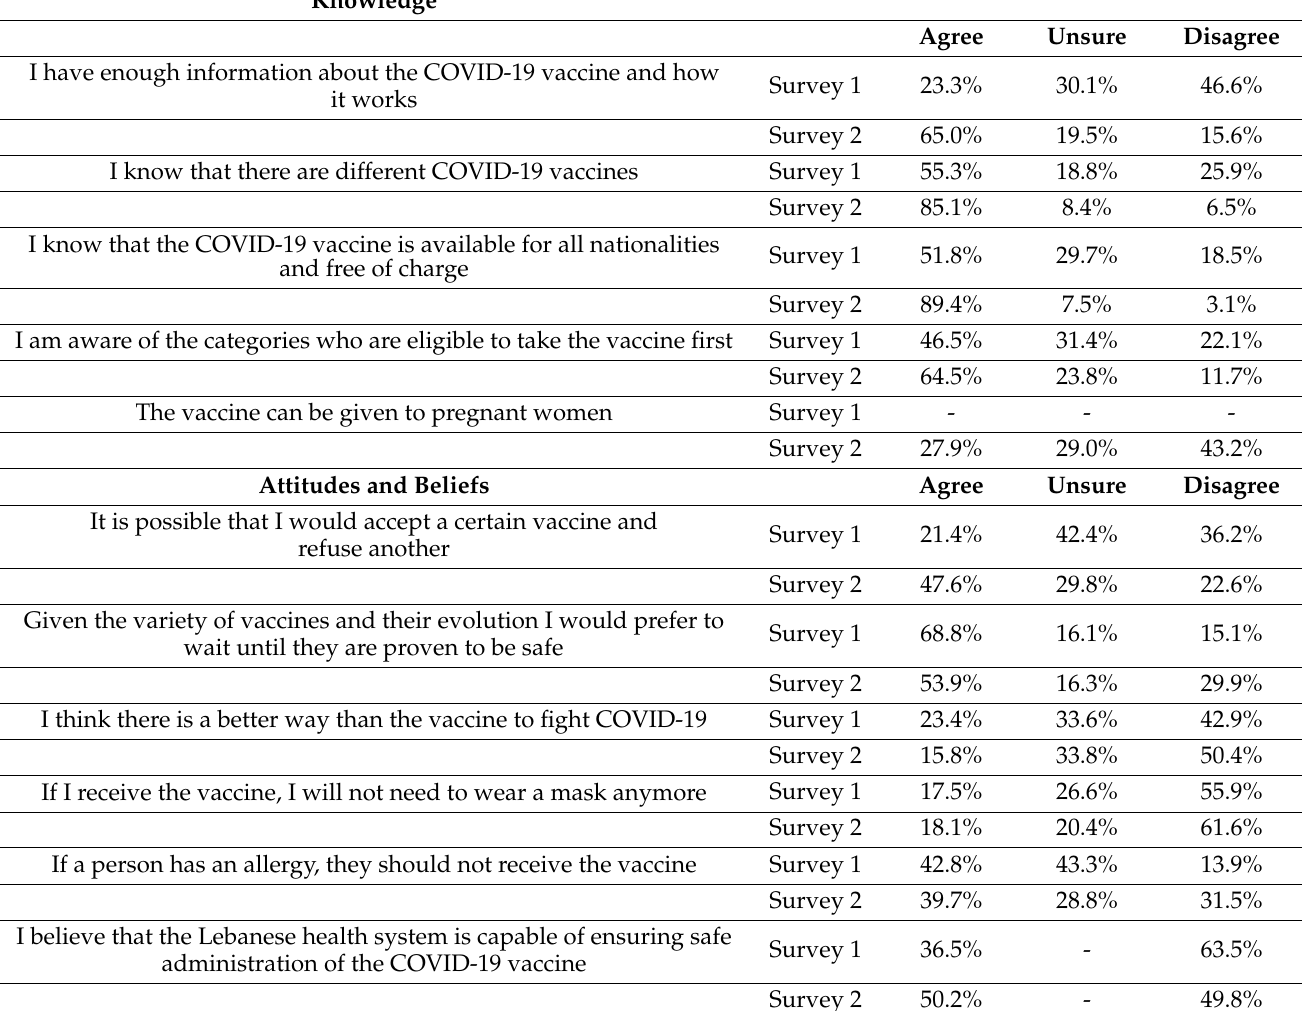
Table 3. Knowledge, attitudes, and beliefs regarding the COVID-19 vaccines in Survey 1 (pre-vaccine rollout) and Survey 2 (post-vaccine